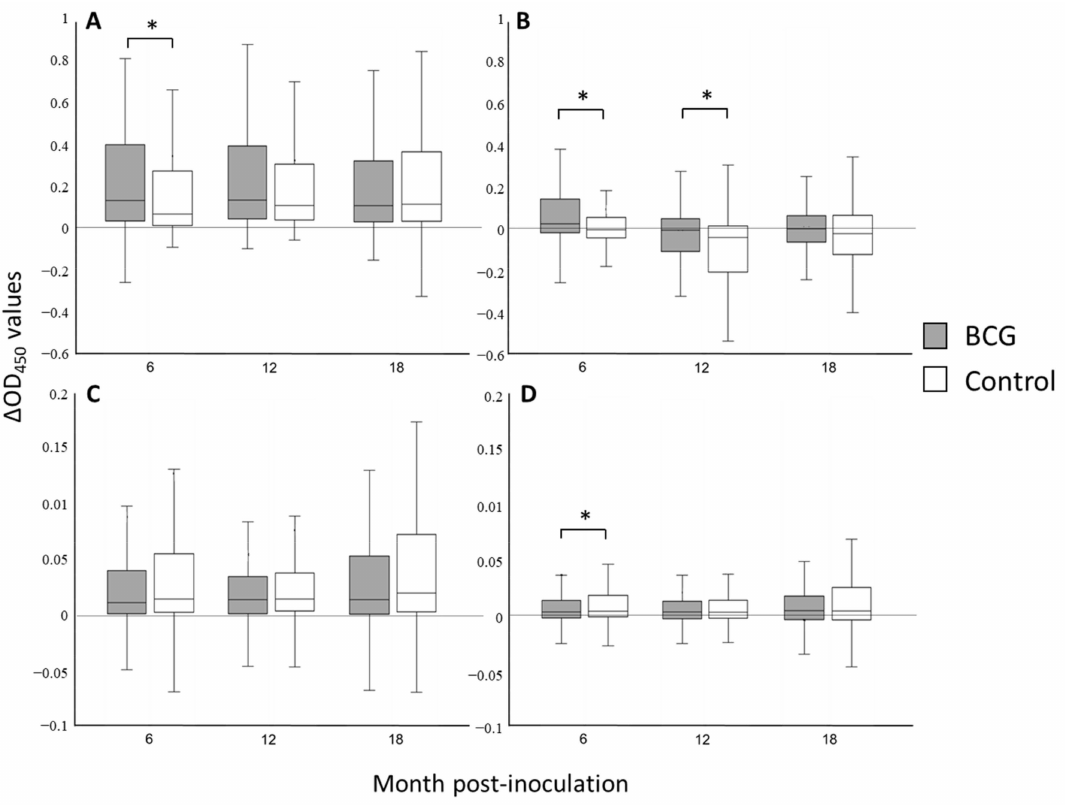
Figure 2. Box-plot diagrams showing IFN-gamma responses at 6, 12 and 18 months post-inoculation in BCG and control groups. The figure shows the IFN-gamma release assay (IGRA) results ( ∆ OD 450 ) obtained with ( A ) PPDB minus saline, ( B ) PPD B-A (bovis minus avium), ( C ) CFP-10/ESAT-6 peptide cocktail minus saline and ( D ) RV3615c cocktail minus saline. Within box-plot diagrams, the median is represented with a line, the interquartile range with a box, and the minimum and maximum of the data with the whiskers. (* p <